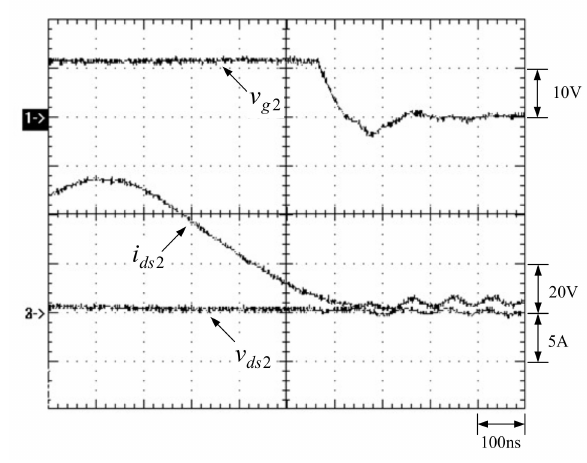
Figure 17. Zoom-in of Figure 15 for ZCS turn-on of S 2 .